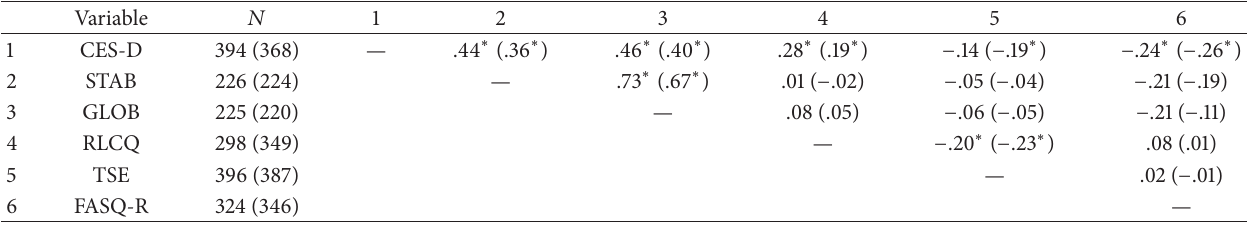
Table 1: Correlational Matrix for Independent Variables at Phases 2 and 3 with depressive symptoms (CES-D) at Phases 2 and 3. Variable